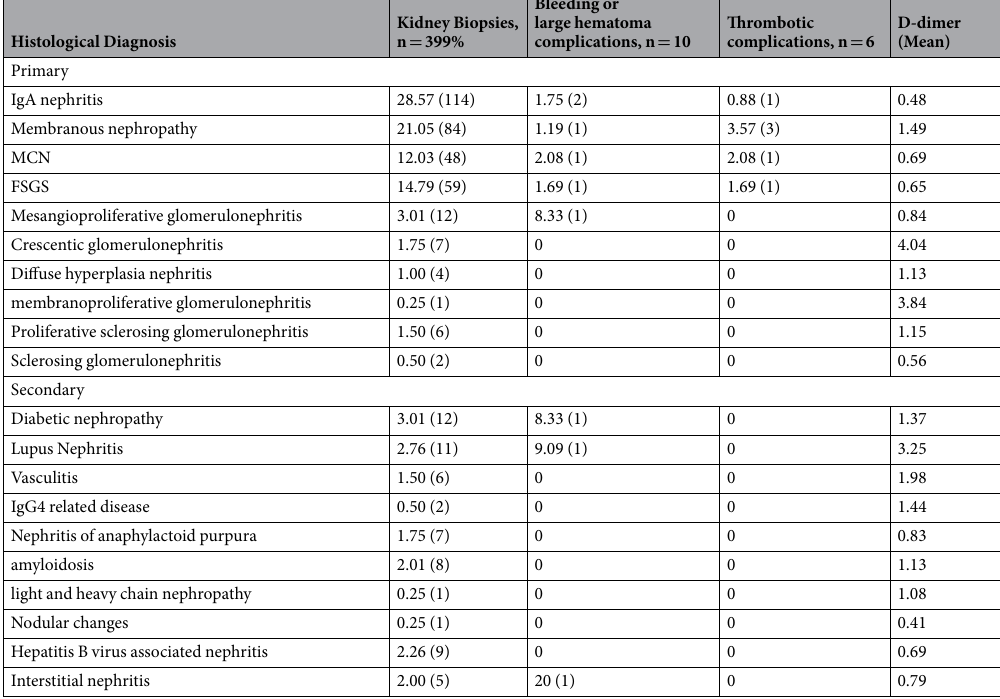
Table 5. Distribution of Histological Diagnoses, Thrombotic or Bleeding complications, and